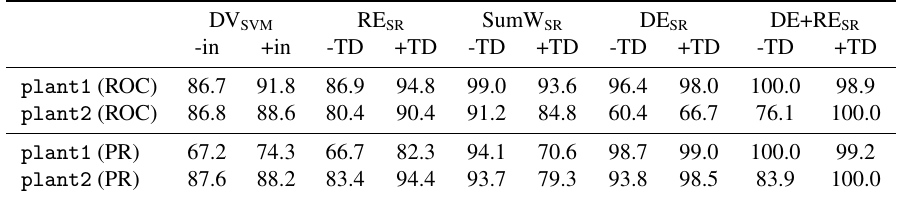
Table 2: Area under curve statistics in [%] for precision-recall curves and receiver operator characteristics. Statistics are given for sparse representation (SR) with topographic dictionary (+TD) and without (-TD). This approach is compared to OCSVM with used inclination information (+in) and without